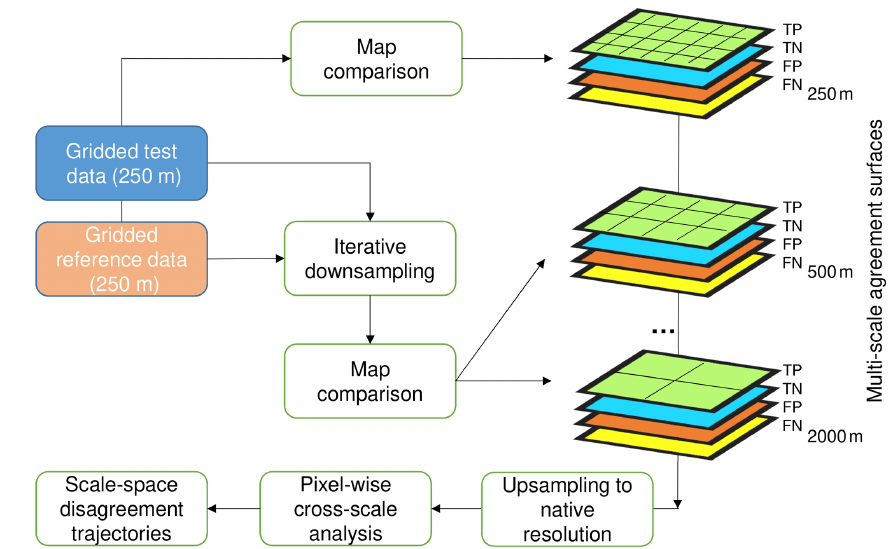
Figure E1. Processing workflow to generate the cross-scale disagreement composite